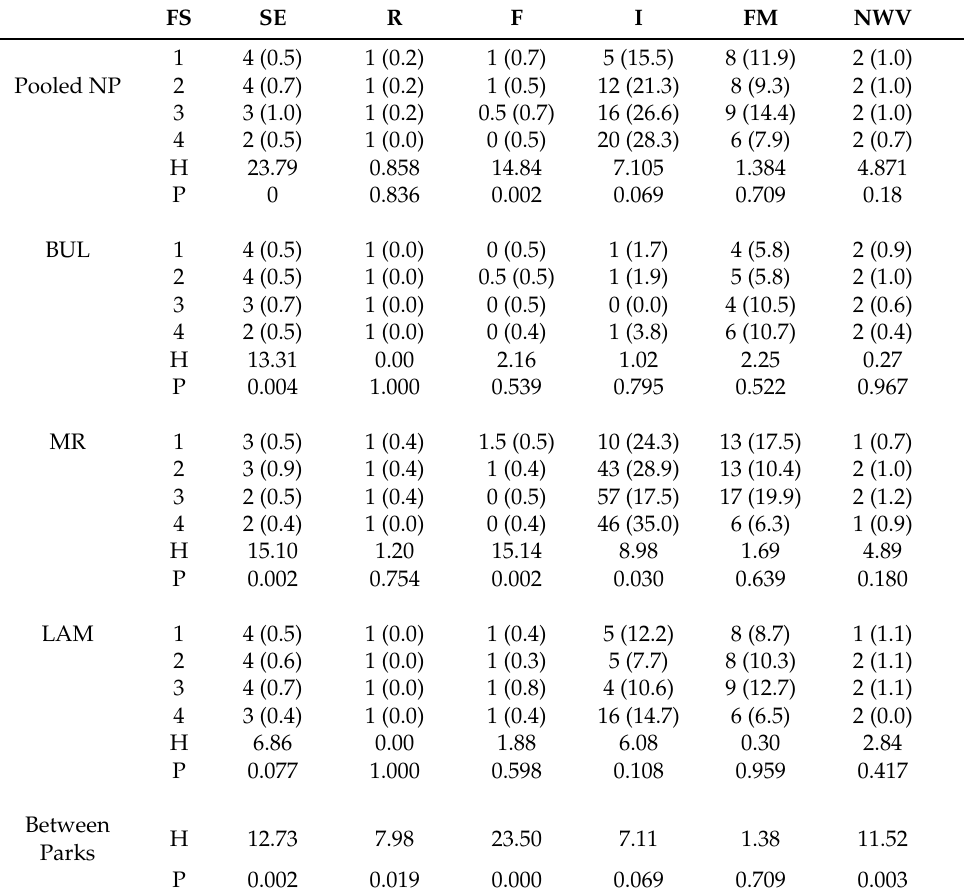
Table 4. Summary table showing the mean and median results of fire-supressing regrowth variables, for each fire-severity class (FS) in each NP, as well as for pooled NP data. For categorical data median values are given with standard deviation in brackets (SE = Seedlings (1 = <10; 2 = 11–50; = 51–100; 4 = 101–500; 5 = 500+), R = Resprouting and F = Ferns (0 = absent, 1 = present and 2 = abundant), NWV = Non-Woody Vines (1 = few vines, 2 = present, 3 = abundant), as well as the Kruskal Wallis H and p -values for comparisons among fire severity (FS). For non-categorical data; (I = Phytolacca octandra (Inkweed) % cover and FM = Fleshy Monocot % cover, the mean values are given with standard deviation values in brackets; Kruskal Wallis H and p -values were given for comparisons among fire-severity categories within each National Park, as well as among the 3 National parks.